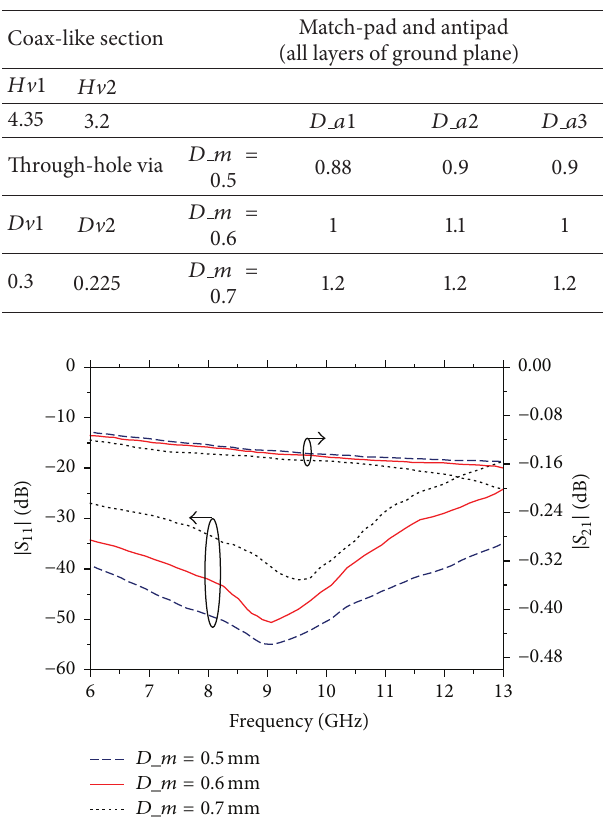
Figure 8: 𝑆 -parameter of three cases for MS-to-MS transition.